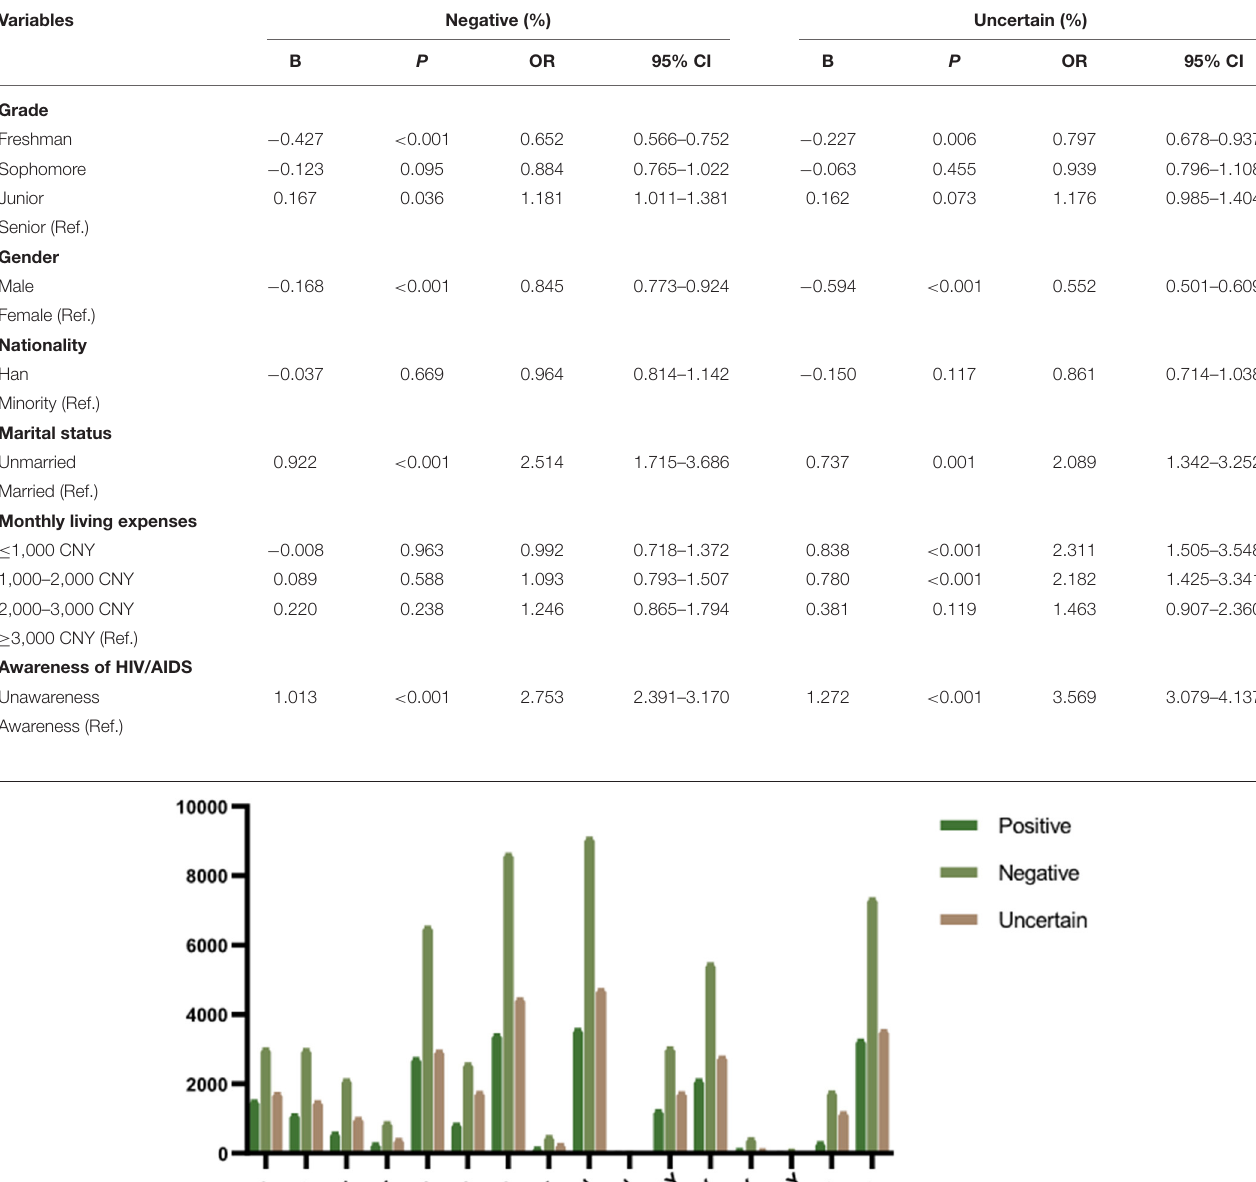
TABLE 4 | Multivariate logistic regression of the attitudes to live with HIV positive roommates. Variables